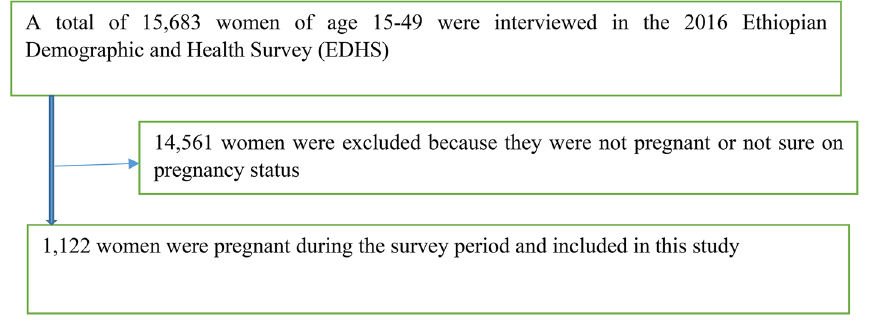
Figure 1. Schematic presentation of selecting the sample from EDHS 2016